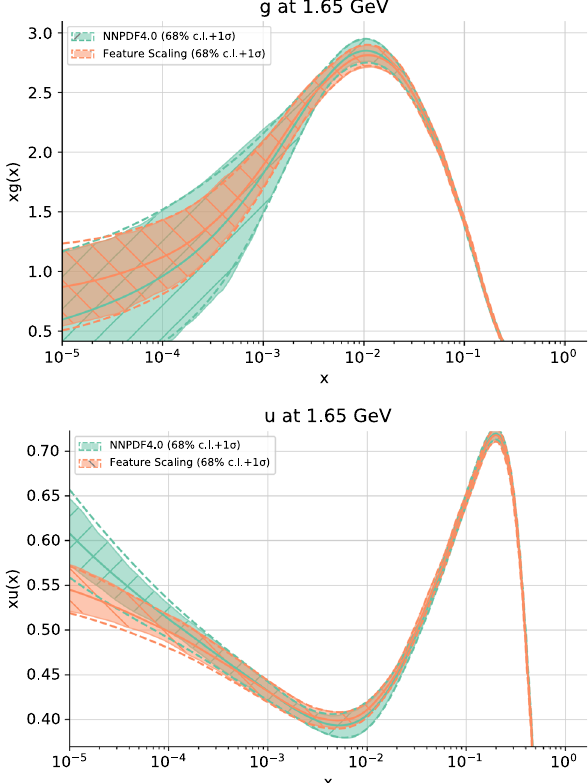
Fig. 6 Comparison of the gluon and u quark PDFs between a fit per- formed with the NNPDF4.0 methodology (green), and one with the feature scaling methodology